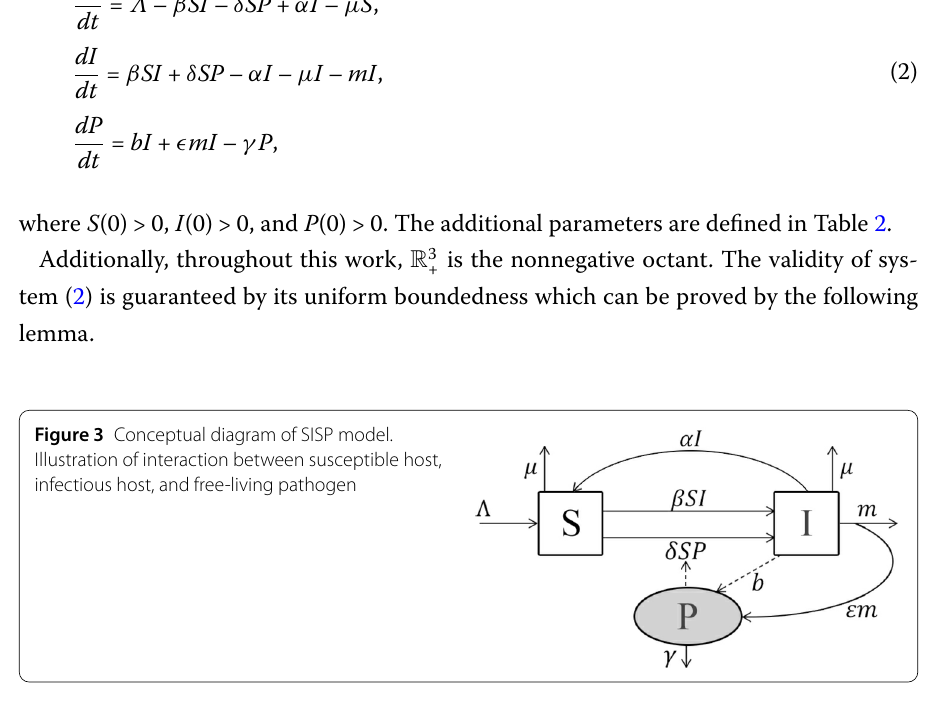
Table 2 Additional parameters and their biological meanings Parameter Biological meaning δ Environment-to-host transmission rate γ The rate at which FLP decay (cid:10) FLP burst released upon death of I b Pathogen releasing rate from host body surface